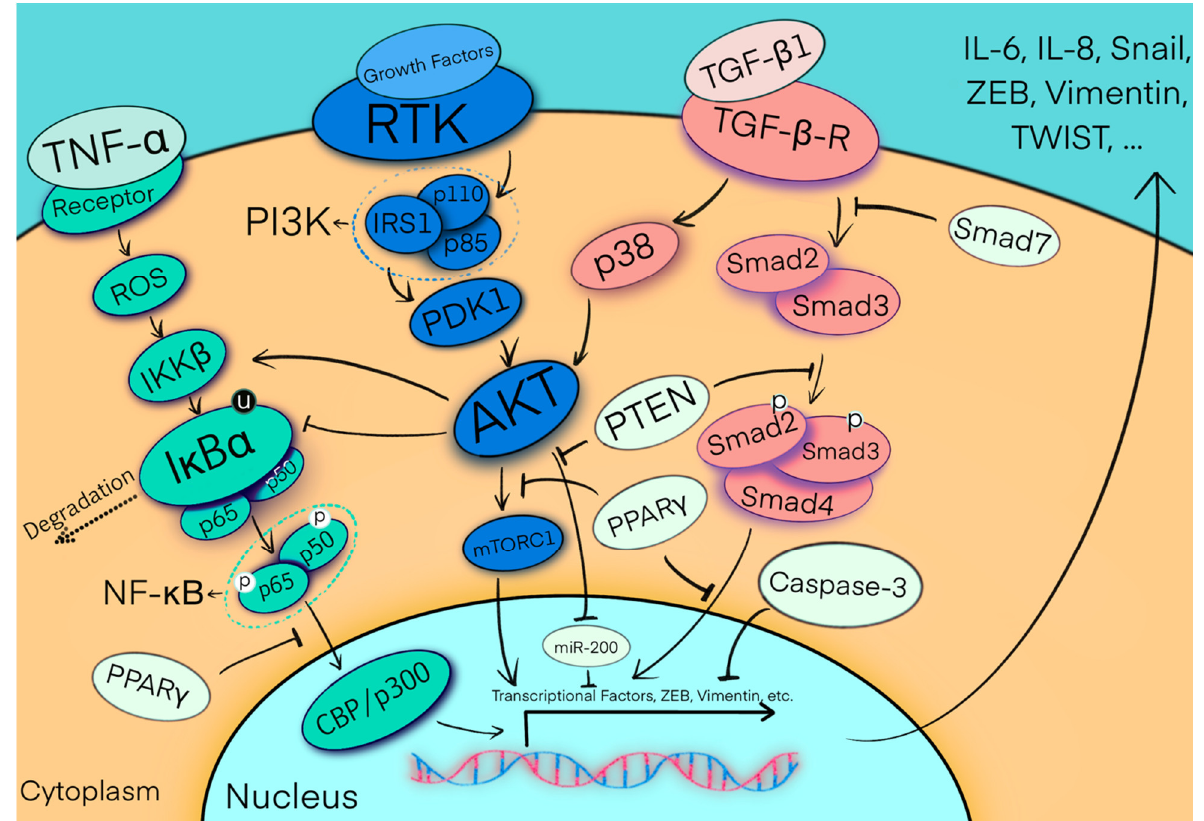
Figure 2. A diagram of the NF-κB (canonical), PI3K/AKT, and TGF-β pathways. NF-κB is shown in the figure as a hetero- dimer consisting of p65 and p50 subunits. In the canonical pathway, NF-κB is bound and inhibited by IκBα proteins. Binding of proinflammatory cytokines, such as TNF-α, to specific transmembrane receptors activates the IKKβ protein, which phosphorylates IκBα and leads to its ubiquitination and, finally, to proteasomal degradation. In this process, ROS interact with NF-κB in various ways, such as by activating IKKβ or IκBα phosphorylation. The active NF-κB complex translocates to the nucleus. For optimal activation of the transcription of NF-κB for certain target genes, interaction with CBP or p300 is required [137,138]. PI3K consists of two domains, p110 and p85, but its activation requires adapter molecules, such as IRS1. Following activation and phosphorylation of the tyrosine kinase receptor (TKR) by growth factors, TKR will recruit PI3K, finally activating AKT by recruiting phosphoinositide-dependent kinase-1 (PDK1) to the kinase domain of AKT.